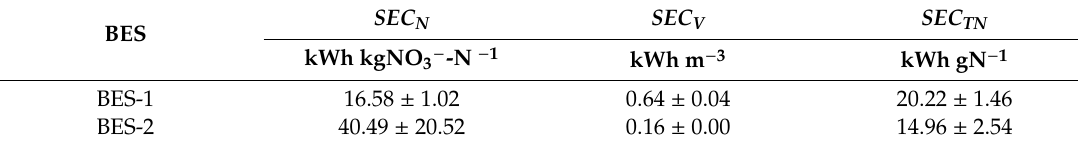
Table 2. Specific energy consumption calculated for each stage and for the sequential system.